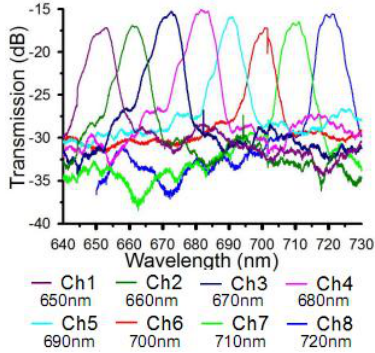
FIGURE 2: Experimental output spectrum of different channels in the AWG spectrometer. The central peaks are indicated correspondingly.